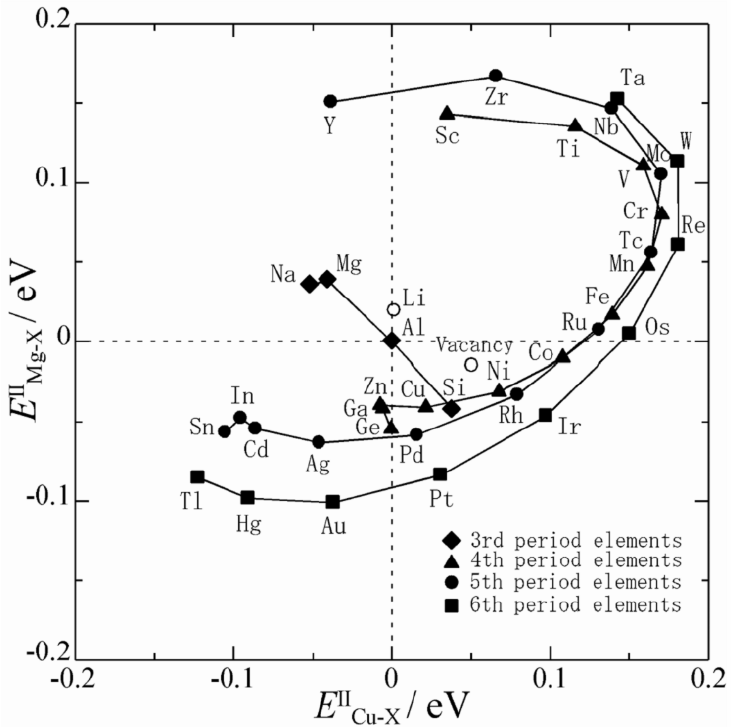
Vacancy-X ( a ), and be- X-X ( b ) for various microalloying elements X